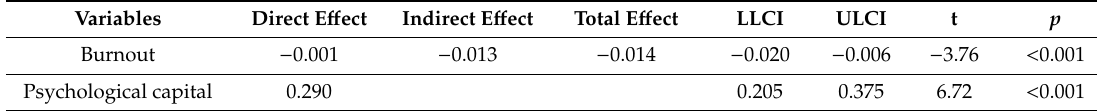
Table 4. Direct and indirect e ff ects on nursing performance outcomes.